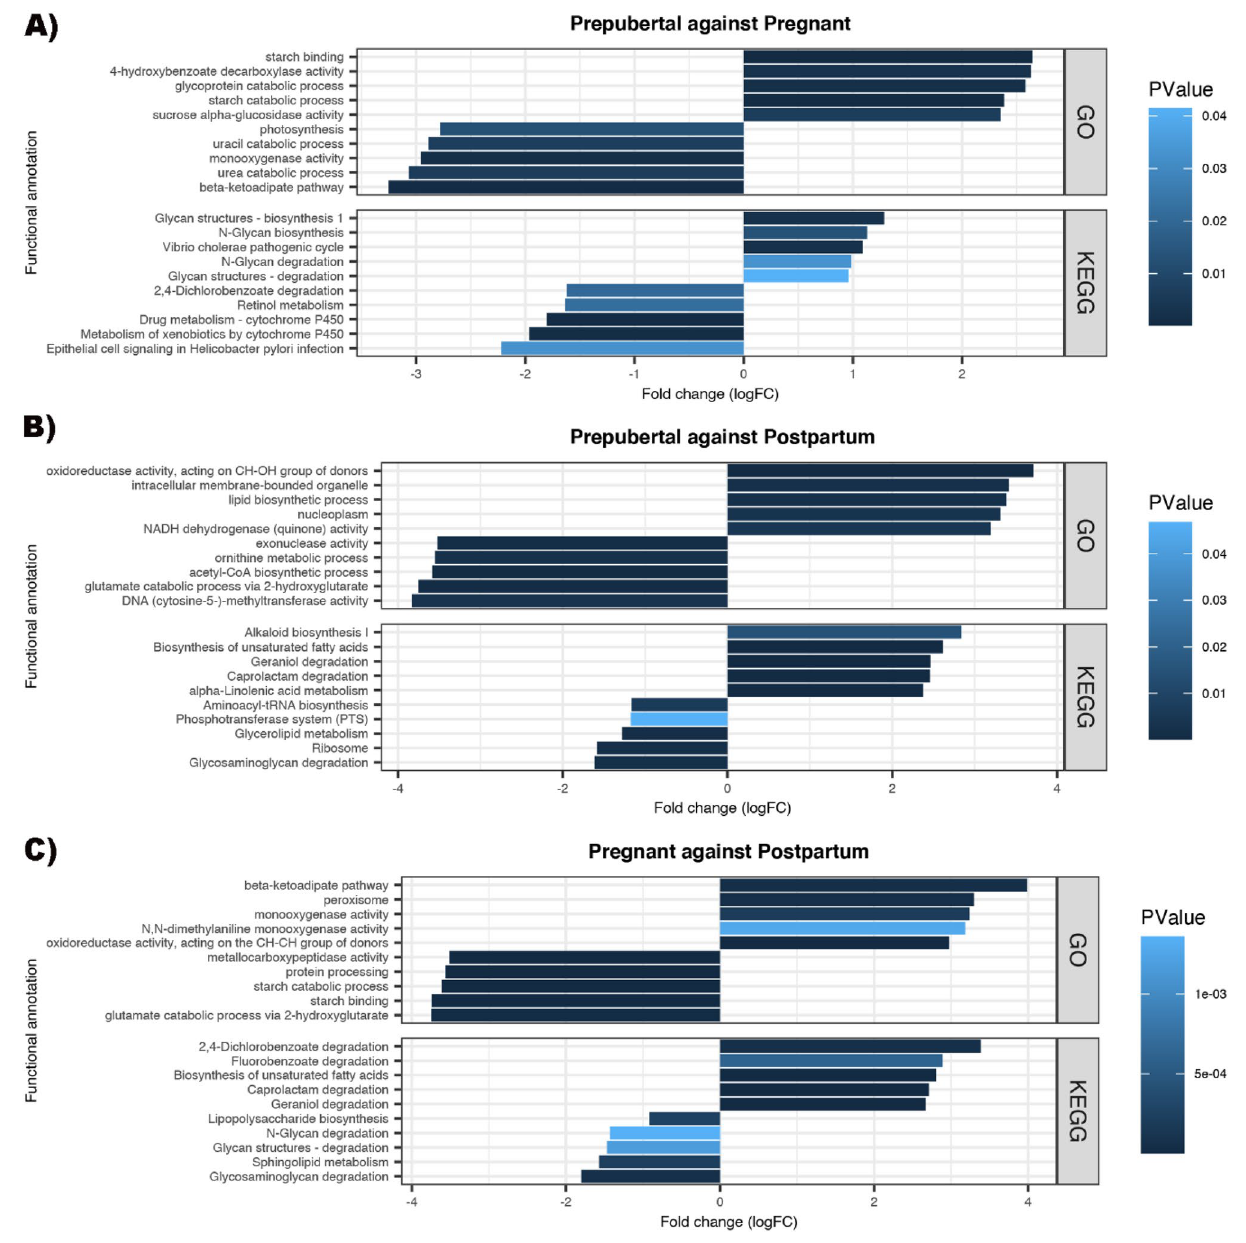
Figure 5. Top 5 significantly more and less expressed GO terms and KEGG pathways of the bovine reproductive metagenome comparing ( A ) prepubertal and pregnant animals, ( B ) prepubertal and postpartum animals and ( C ) pregnant and postpartum